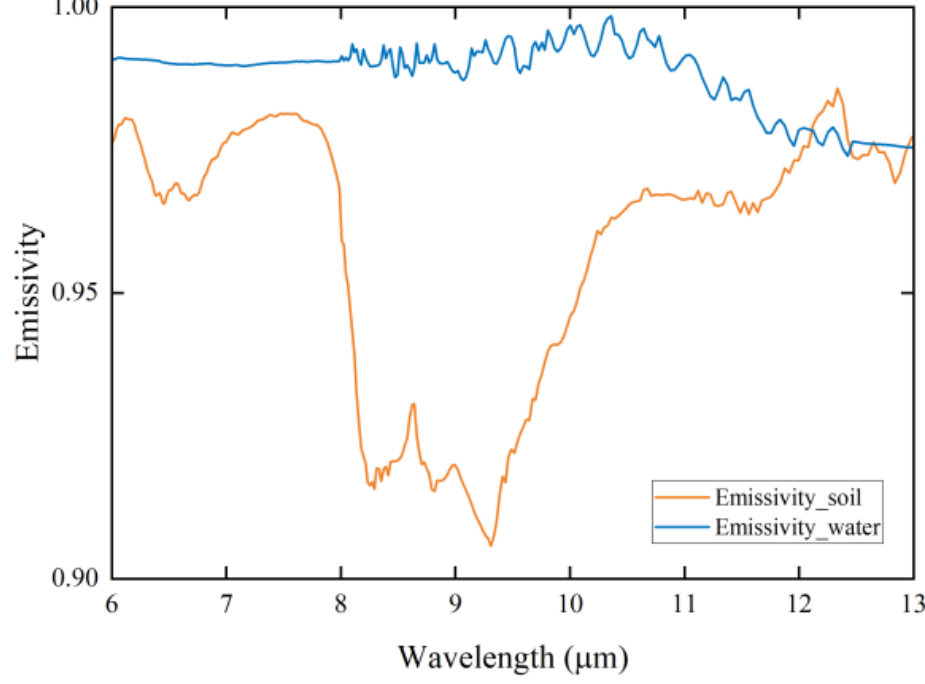
Figure 8. Emissivity curves for water and bare soil in Ulansuhai Nur.